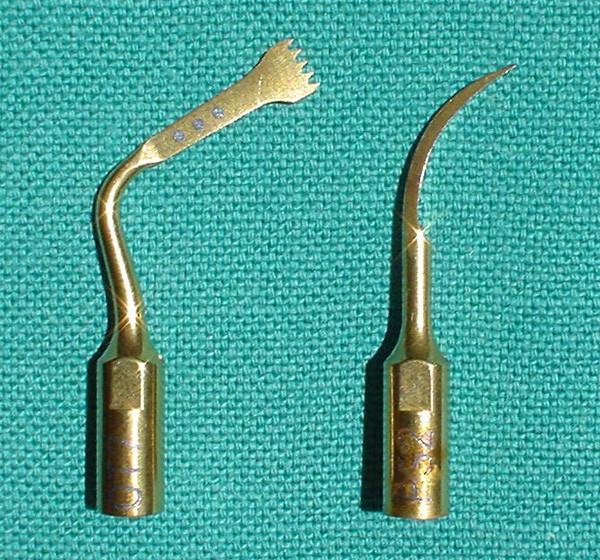
Two examples of available tips. Left side: The preferred blade.